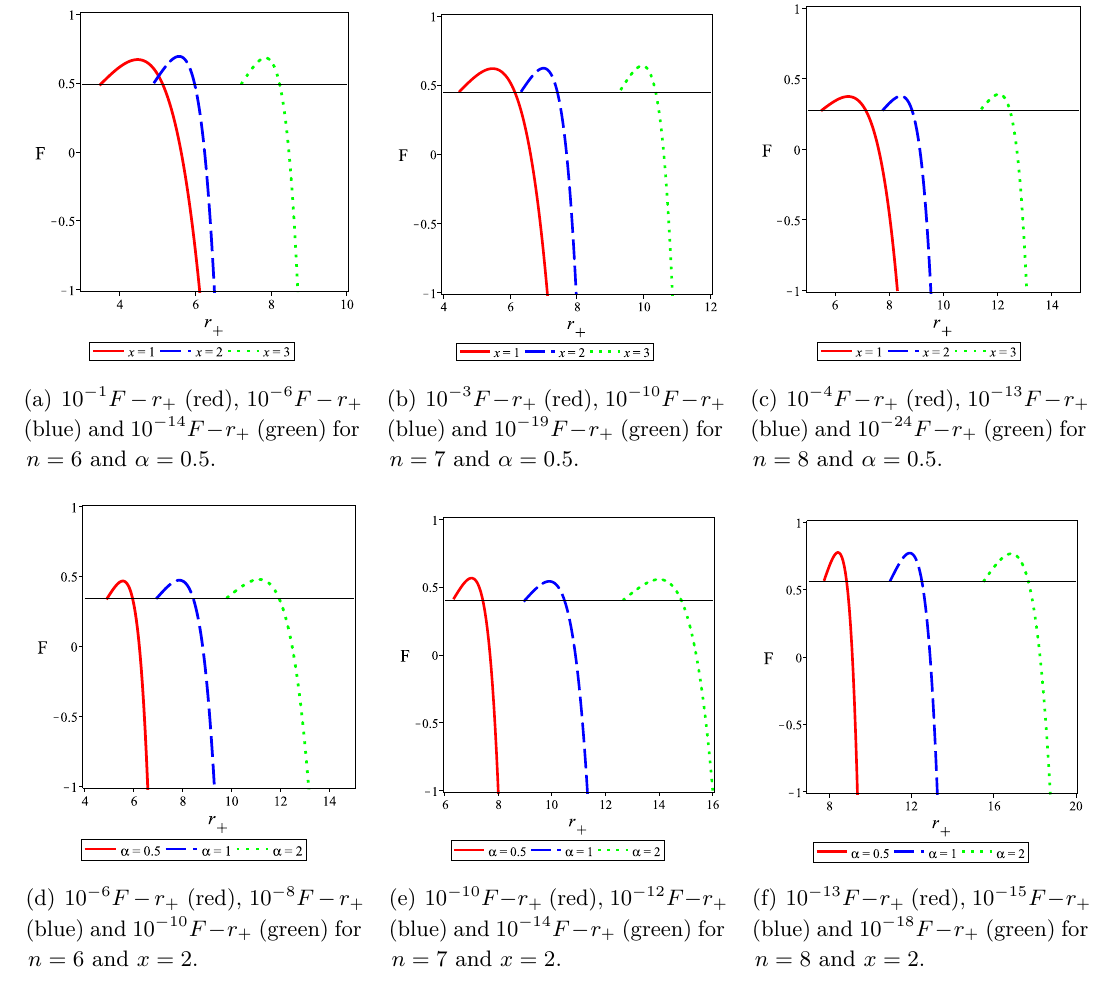
Figure 11 . Behavior of the free energy versus r + for G = 1 and for “ + ” sign